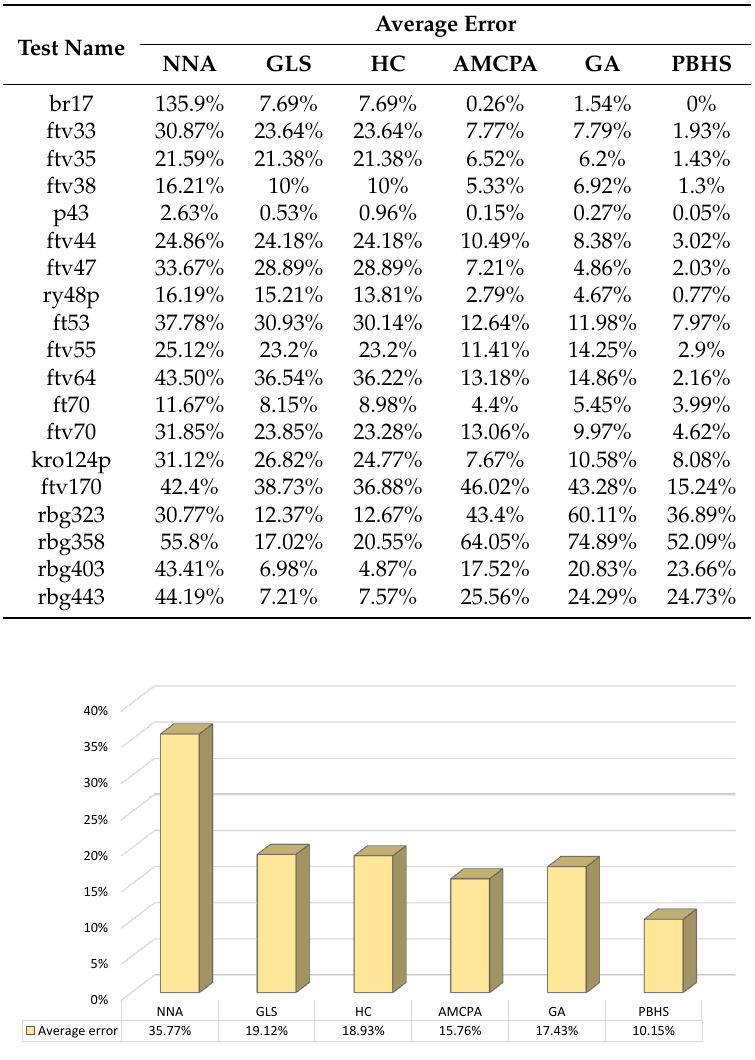
Table 3. Comparison of the average error obtained by PBHS ( ρ = 0.25) and selected methods from the literature on the subject.